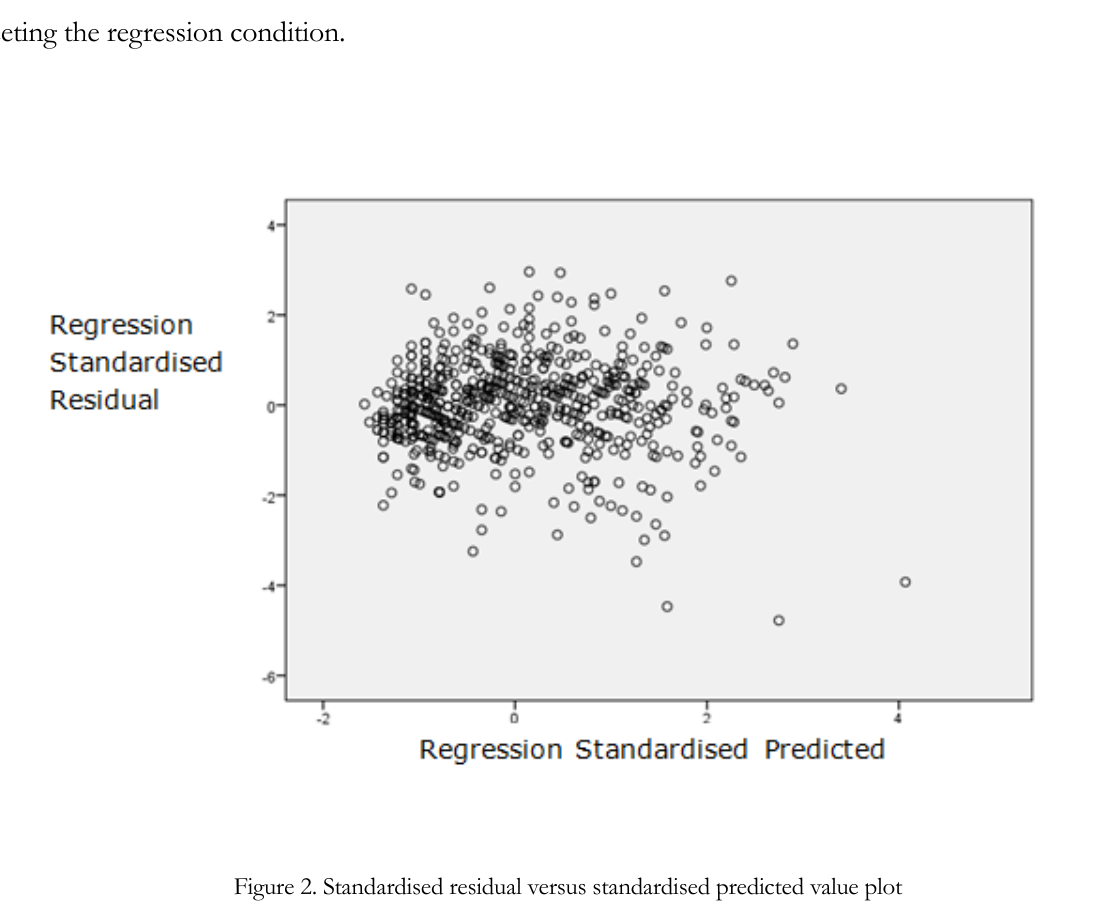
Journal of Industrial Engineering and Management, 2016